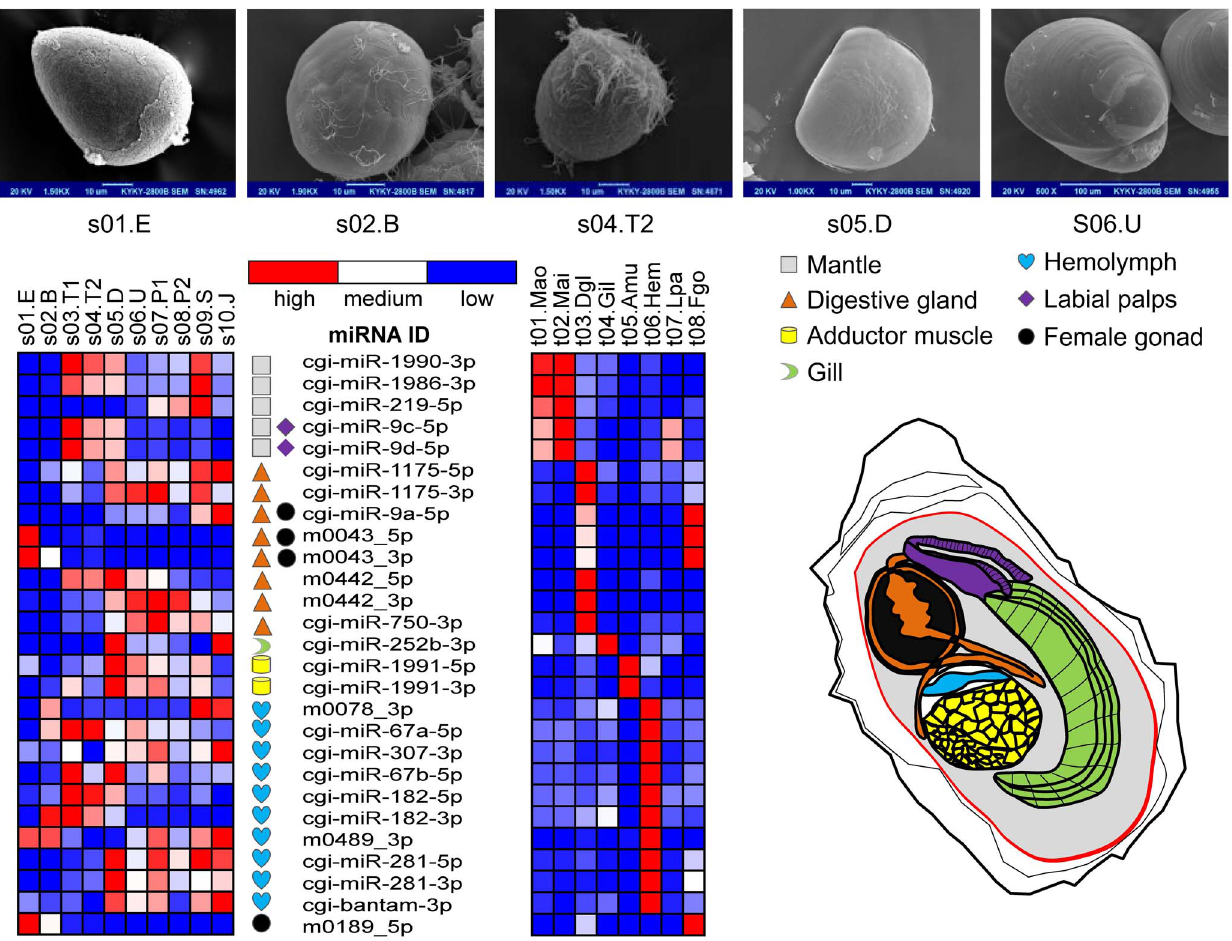
Figure 3. Organ-specific expressed miRNAs and their expression patterns during different development stages and in different organs. The abbreviations of organs and developmental samples in each heat map are as detailed in the legend to Figure 1. A color bar is provided where blue indicates a low expression level, red indicates a high expression level, and the white indicates medium expression levels. The electron microscope (EM) photos show part of the development stages and there is also a sketch of the main adult organs. The EM photos for s04.T2, s05.D, and s06.U were from Zhang et. al. [17]. The organs are indicated with different colors according to the scheme shown in the sketch while they are also indicated in front of the miRNA